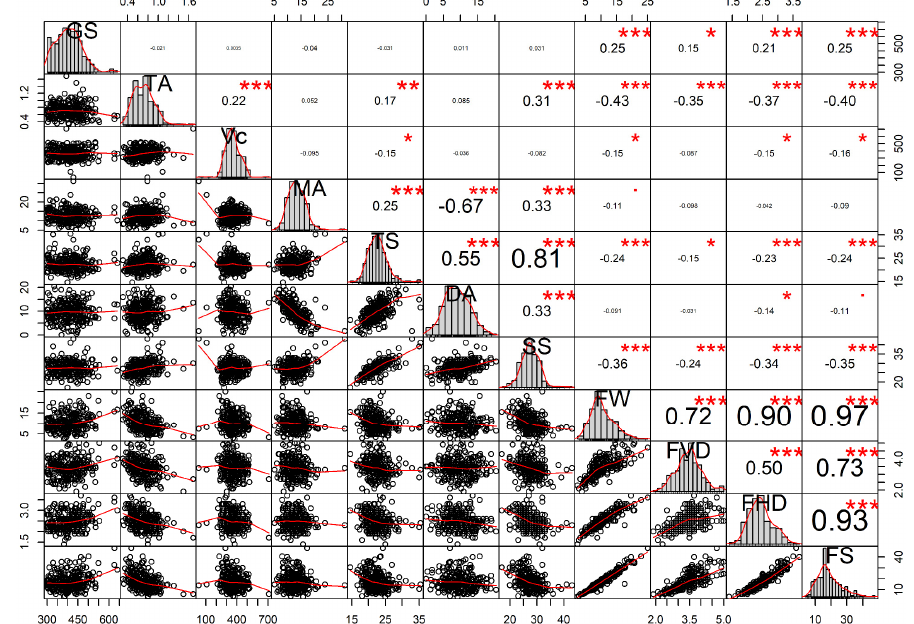
Figure 8. Correlation analyses between genome size and multiple fruit traits. GS: genome size; TA: total acids; Vc: ascorbic acids; MA: monosaccharides; TS: total sugars; DA: disaccharides; SS: soluble solids; FW: fruit weight; FVD: fruit vertical diameter; FHD: fruit horizontal diameters; FS: fruit sizes; The x and y axes for each plot is dependent on where the plot is. For example, the y axes for all plots in the first column are all GS, and the x axes for all plots in the bottom row are all FS. Therefore, the bottom plot in the first column has a y -axis of GS and an x -axis of FS. Asterisks *, **, and *** represent the statistical significance di ff erences of p -values < 0.05, 0.01, and 0.005 (Student’s t -test),